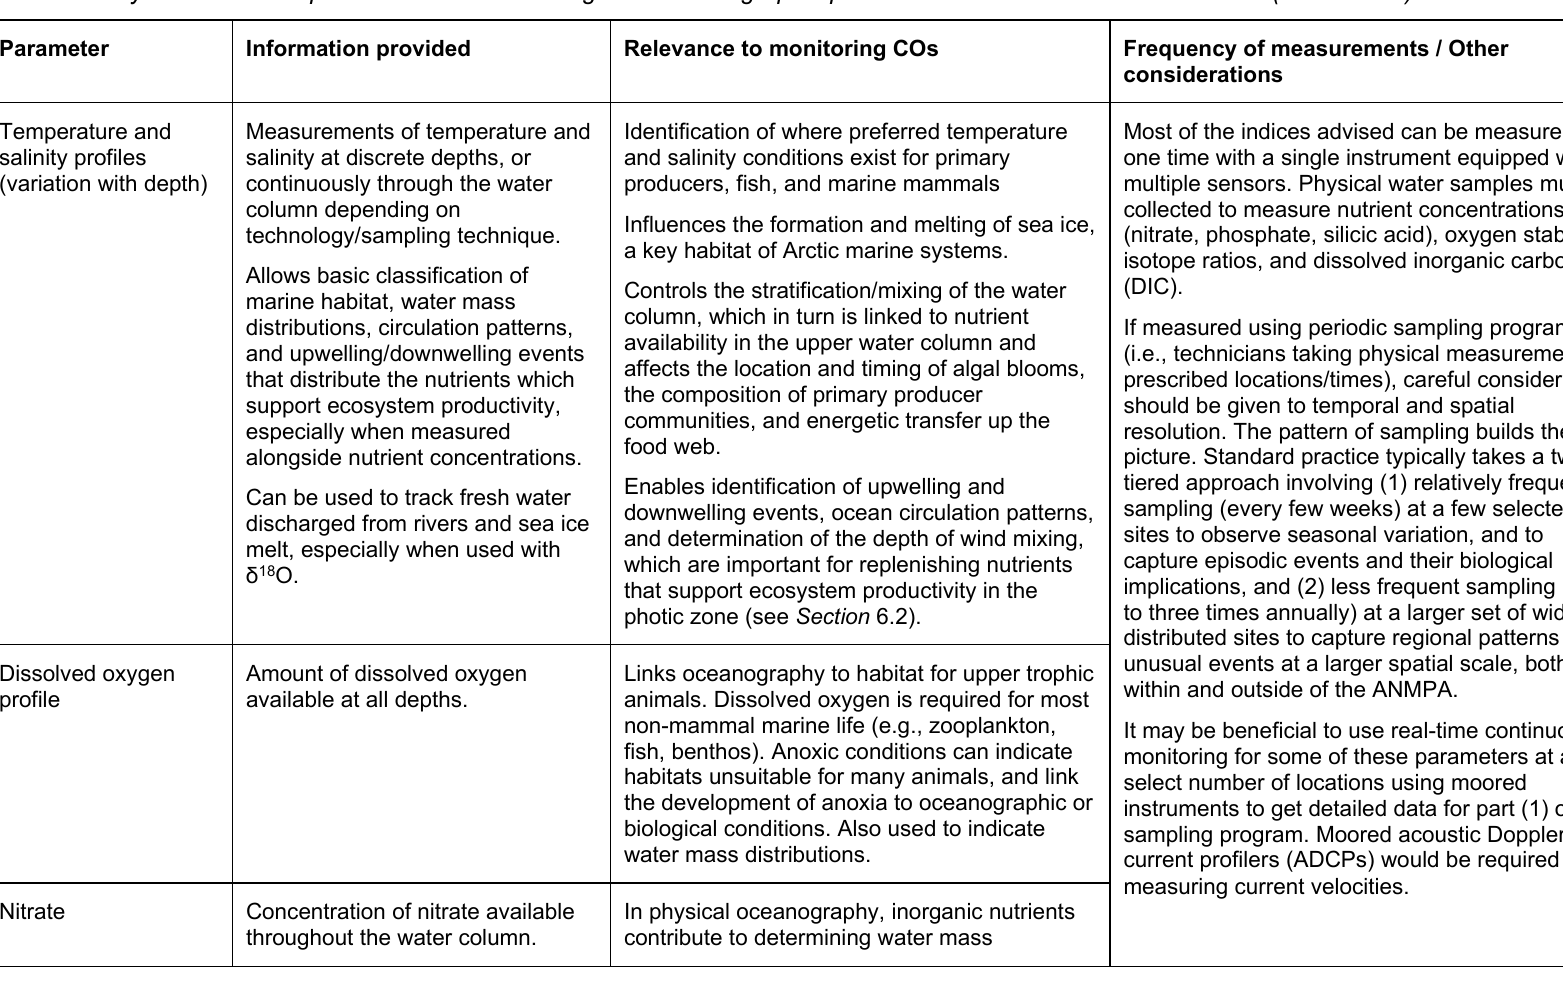
Table C1. Key measurement parameters for monitoring core oceanographic parameters and nutrient concentrations (Section